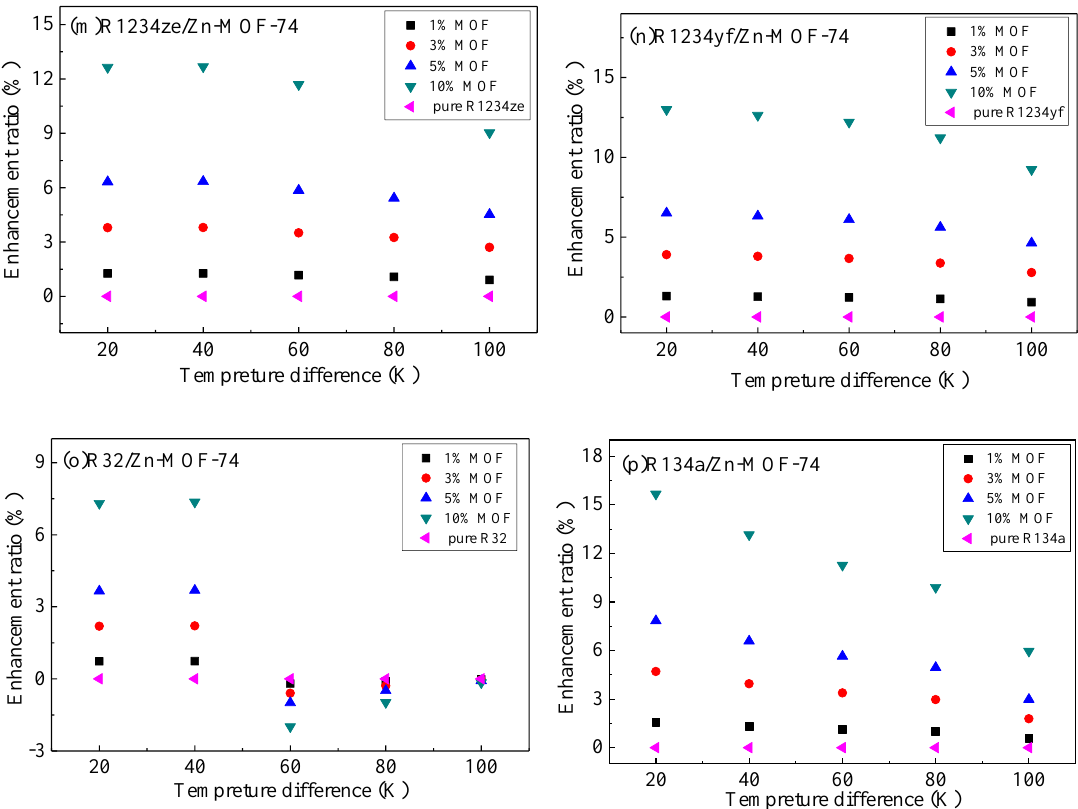
Figure 7. The relationship between the thermal energy storage and temperature difference of the adsorbates (R1234yf, R1234ze, R134a, R32)/MOF-74 mixture at 5,000 kPa. ( a ) R1234ze/Co-MOF-74; ( b ) R1234yf/Co-MOF-74; ( c ) R32/Co-MOF-74; ( d ) R134a/Co-MOF-74; ( e ) R1234ze/Mg-MOF-74; ( f ) R1234yf/Mg-MOF-74; ( g ) R32/Mg-MOF-74; ( h ) R134a/Mg-MOF-74; ( i ) R1234ze/Ni-MOF-74; ( j ) R1234yf/Ni-MOF-74; ( k ) R32/Ni-MOF-74; ( l ) R134a/Ni-MOF-74; ( m ) R1234ze/Zn-MOF-74; ( n ) R1234yf/Zn-MOF-74; ( o ) R32/Zn-MOF-74; ( p ) R134a/Zn-MOF-74.